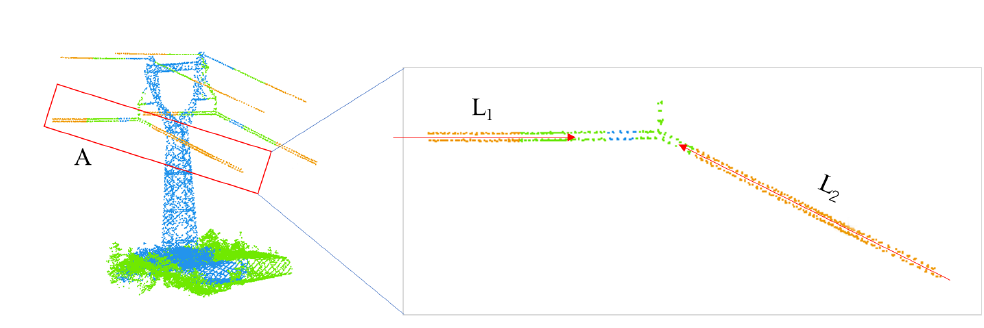
Figure 10. Completion of power line points based on fitting the clusters in the